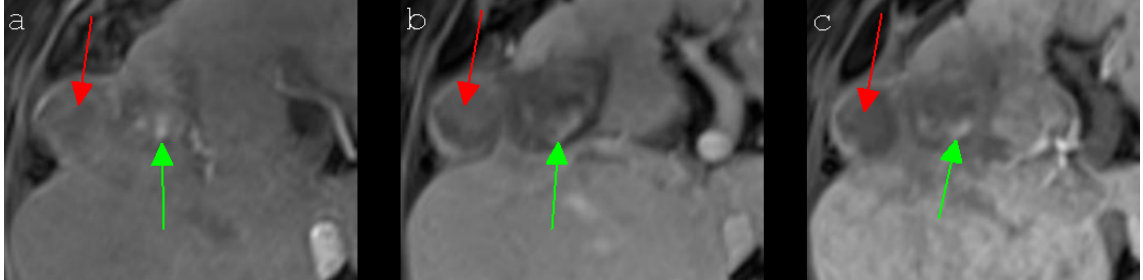
Figure 5. A 67-year-old man with a local tumor progression in the peripheral ablation zone (segment VIII/Iva) six months after IRE of an HCC, which presented atypical signal behavior in Gd-EOB-DTPA-based MR imaging. The nodular, exophytic HCC (red arrow) showed a slight peripheral enhancement and a central hypointensity in the contrast-enhanced T1 arterial phase MR image ( a ), the typically known hypervascularization was lacking, however. The signal intensities of the HCC remained unchanged during the contrast-enhanced T1 portal venous phase ( b ) and the contrast-enhanced T1 delayed phase MR image ( c ). A typical “wash-out” could not be observed. The central part of the ablation area showed several hyperintense spots (green arrow), which could be detected in all presented MRI sequences ( a – c ), attributable to post-interventional hemorrhagic transformation.